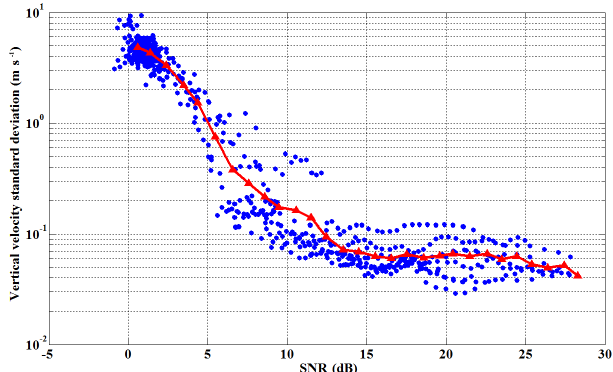
Figure 15. Random error of the CDL vertical velocity from 07:33 to 15:29LT on 14 May 2014 in all height ranges, which is determined from the frequency spectrum of the retrieved vertical velocity. The averaged random error per SNR bin is shown in red-triangle